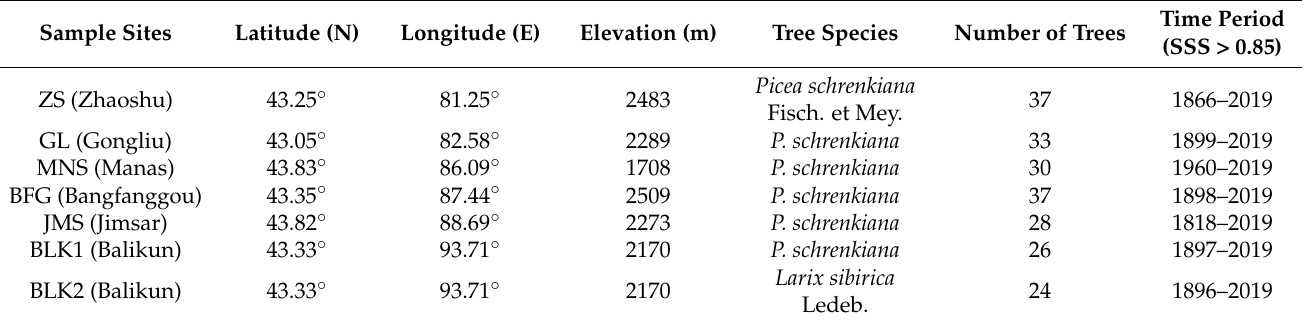
Figure 1. Locations of the sampling sites in the Tianshan Mountains. Table 1. Sampling site information.